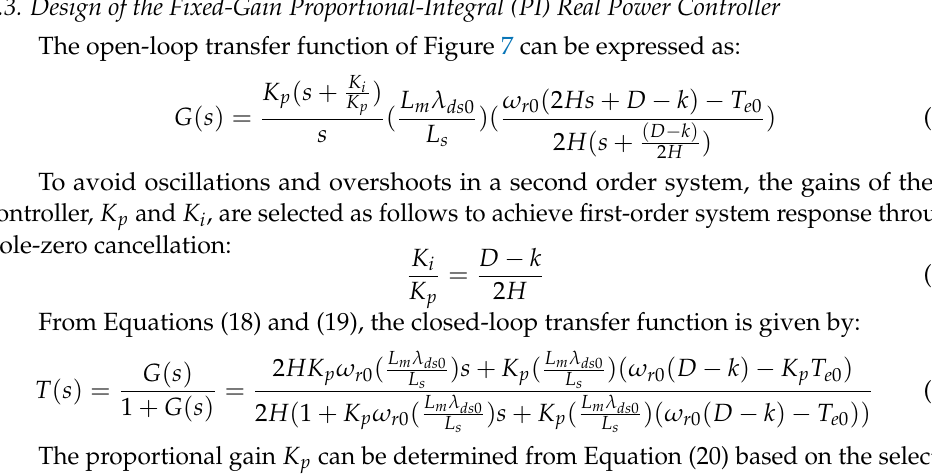
Figure 7. Simplified linear model for DFIG real power controller design. 3.3. Design of the Fixed-Gain Proportional-Integral (PI) Real Power